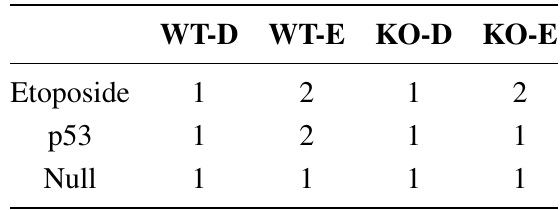
Table 2. Patterns for multiple conditions comparison. Entries correspond to the population mean which sample is assumed to come from, given the pattern indicated. Pattern names are indicated in the row, whereas samples are indicated in the columns. WT: